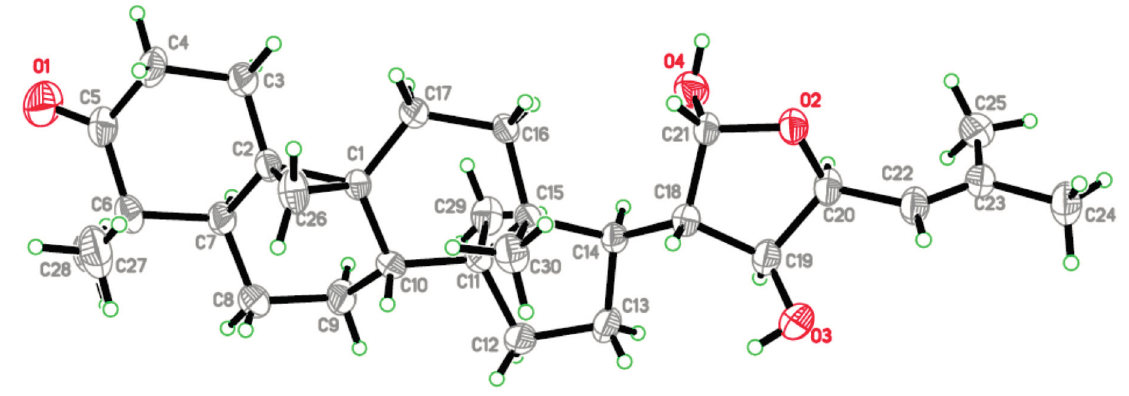
Figure 3. ORTEP drawing for 1